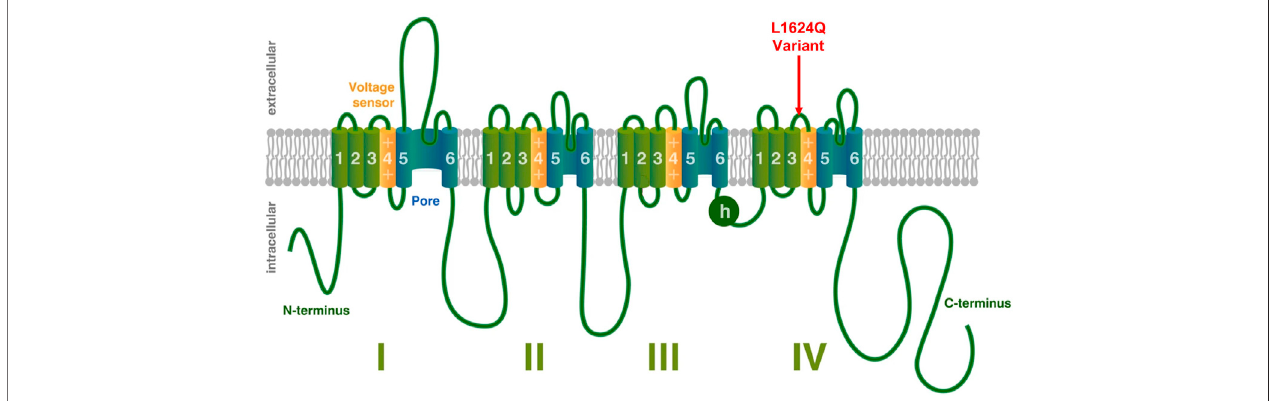
FIGURE1| Voltage-GatedSodiumChannelStructure.Structuraldepictionofamammalianvoltage-gatedsodiumchannel,modi fi edfrom(Petersetal.,2016).The location of the L1624Q variant is shown with a red arrow. Other emphasized regions include the S4 voltage-sensing segments (yellow), the pore-forming regions (blue), and the intracellular loop involved in fast inactivation